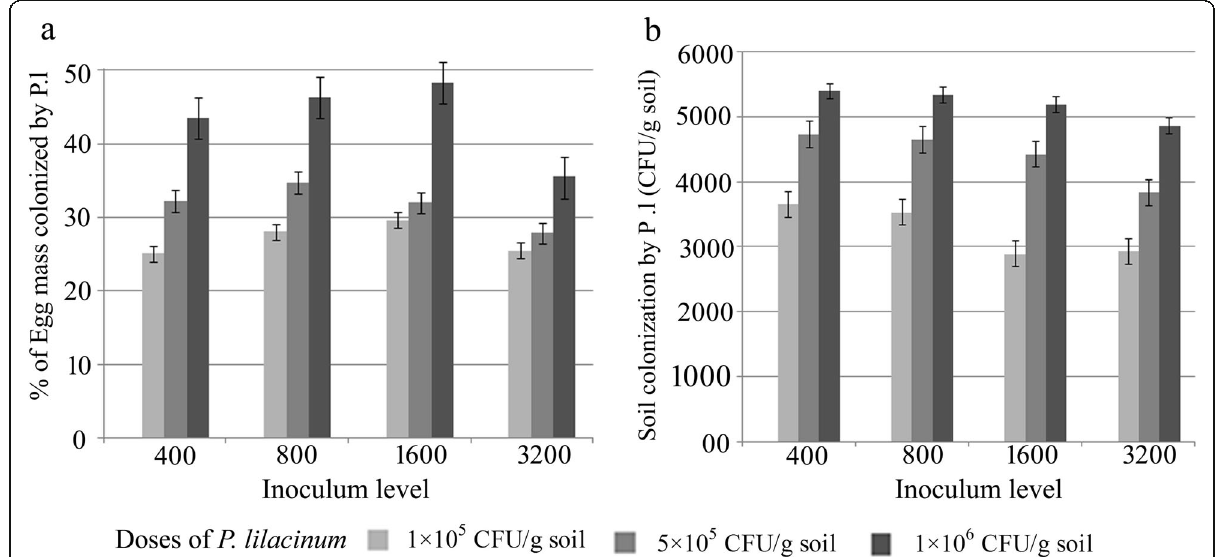
Fig. 1 Dose-response relationship of M. incognita and P. lilacinum PLSAU-1 on a percentage of egg mass colonization and b colonization of fungus/g soil in